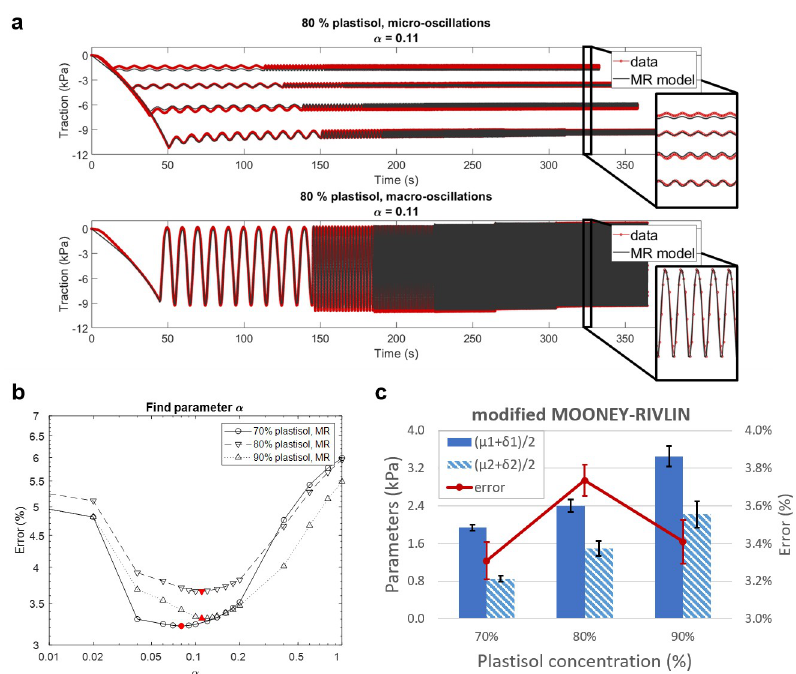
Fig 7. Modelling the rheological behaviour of the plastisol phantoms. (a) Example of the best fit of the rheological data acquired from the 70% plastisol sample. Overall the modified Mooney-Rivlin model proved able to reproduce the induced oscillations even at the highest employed frequency. The nonlinear increase in traction was also captured, as well as the relaxation process visible over the explored time-frame. (b) Data from different plastisol concentration are modelled by equally small fractional derivative orders. A fitting error smaller than 4% was obtained for α values between 0.05 to 0.2. The actual minimum, α min , is indicated by a filled symbol. (c) Best estimated parameters over fractional derivative orders going from 0.05 to 0.2. Given the parameter coupling, the means of the parameters scaling the linear terms and of those scaling the quadratic ones were considered. The error bars represent the range of values assumed over the selected α range, centred on the average value. The same approach was used for the fitting error.